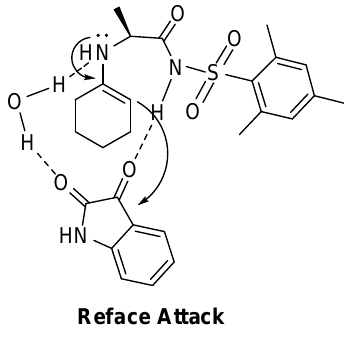
Figure 8. Proposed reaction mode of aldol reaction.